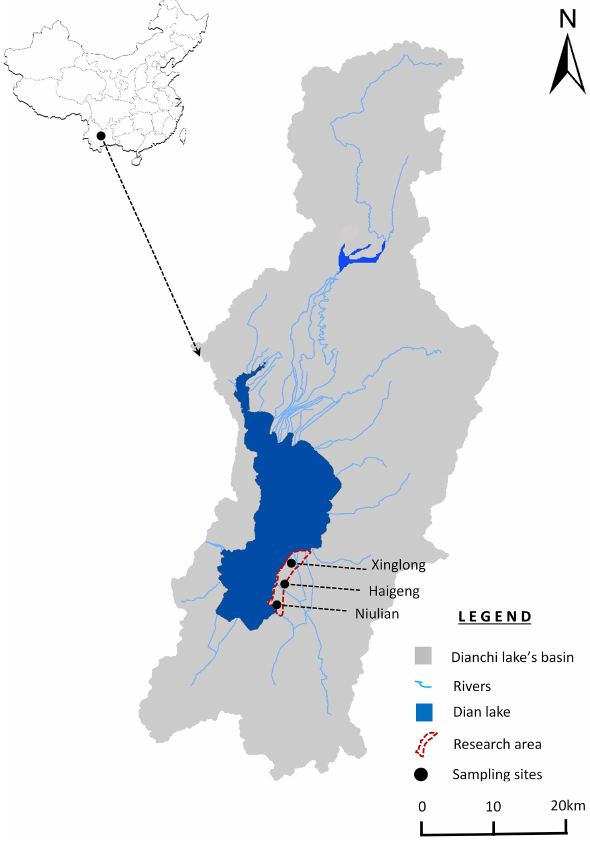
Figure 1. Map of the research area with sampling